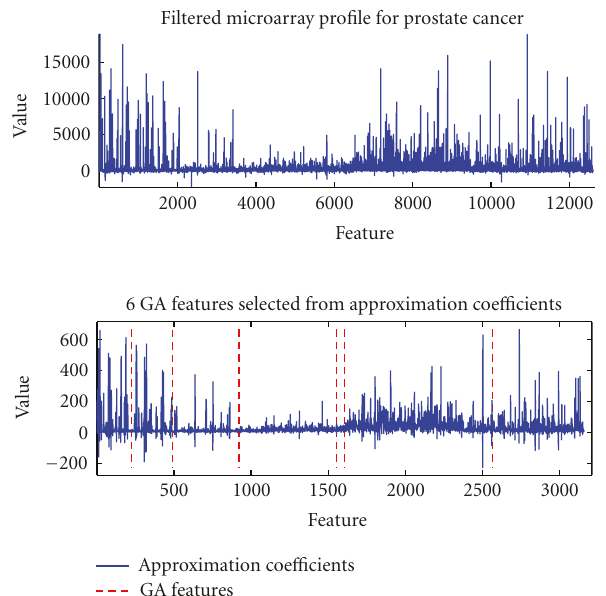
Figure 6: Approximation coe ffi cients at 2nd level and selected GA features.